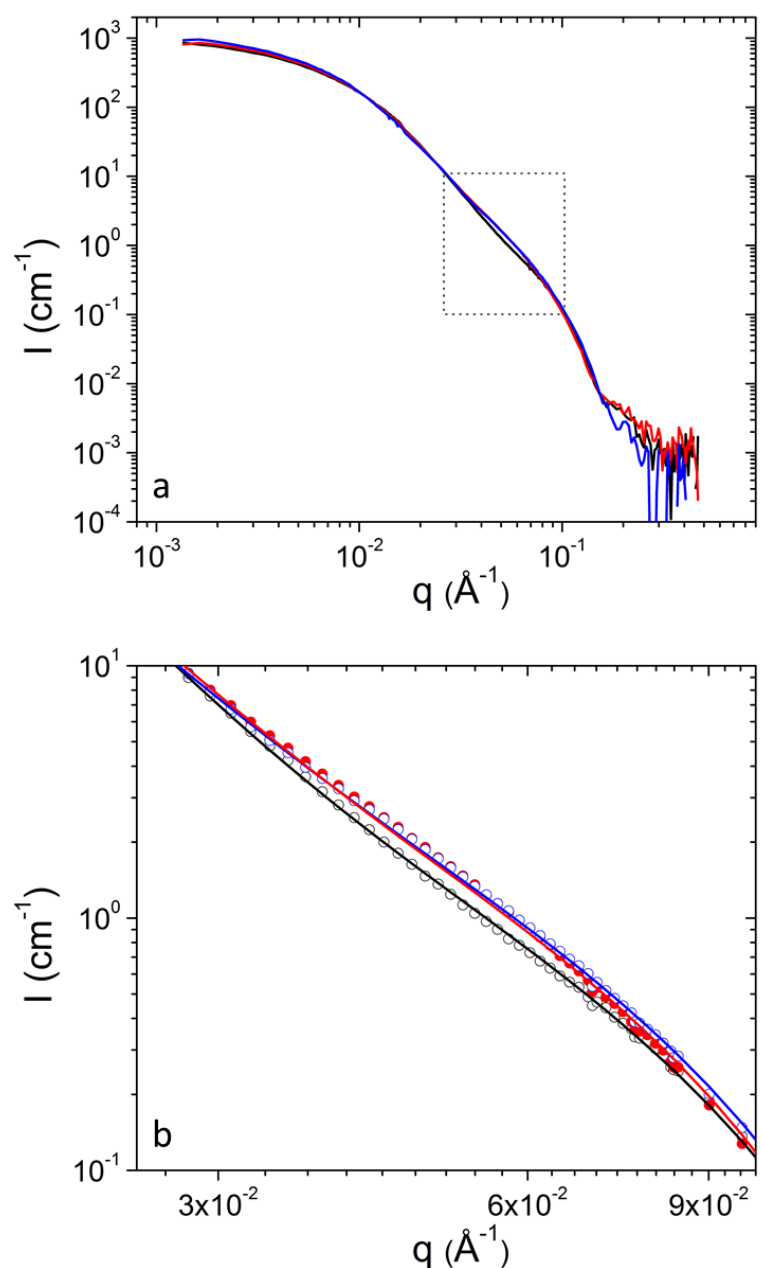
Figure 3. ( a ) SANS profiles from DPPC/PEO-b-PCL1 at 30 mg mL − 1 at 25 ◦ C (black), 37 ◦ C (red) and 45 ◦ C (blue). ( b ) Magnification of the region in rectangular from ( a ). Fitting lines are shown with the same color as the corresponding experimental data.